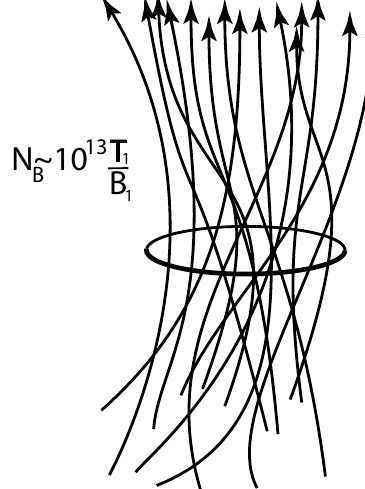
Fig. 2. A few of the N B = T e / ¯ hω ce magnetic field lines belonging to the bundle of field lines (flux elements of diameter 2 λ m ) that are contained in the cross section of an electron gyration ( T 1 = T e in eV, B 1 = B in nT). Because flux can only annihilate in quanta, implying that only strictly antiparallel field line segments reconnect, none of these field lines can reconnect, however, even though they may get in touch at some inclination angle. Reconnection requires that at least some genuinely antiparallel external field lines are added from the outside. This happens in colliding magnetised plasmas with oppositely directed fields where some field lines will always find their strictly antiparallel